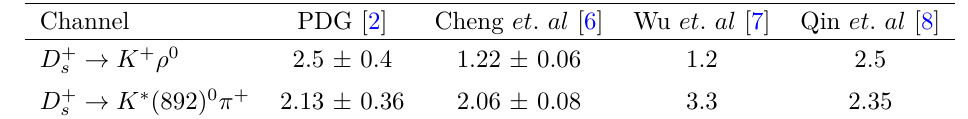
Table 1 . The experimental measurements and theoretical predictions of the BFs of D + and D + → K ∗ (892) 0 π + ( × 10 − 3 s